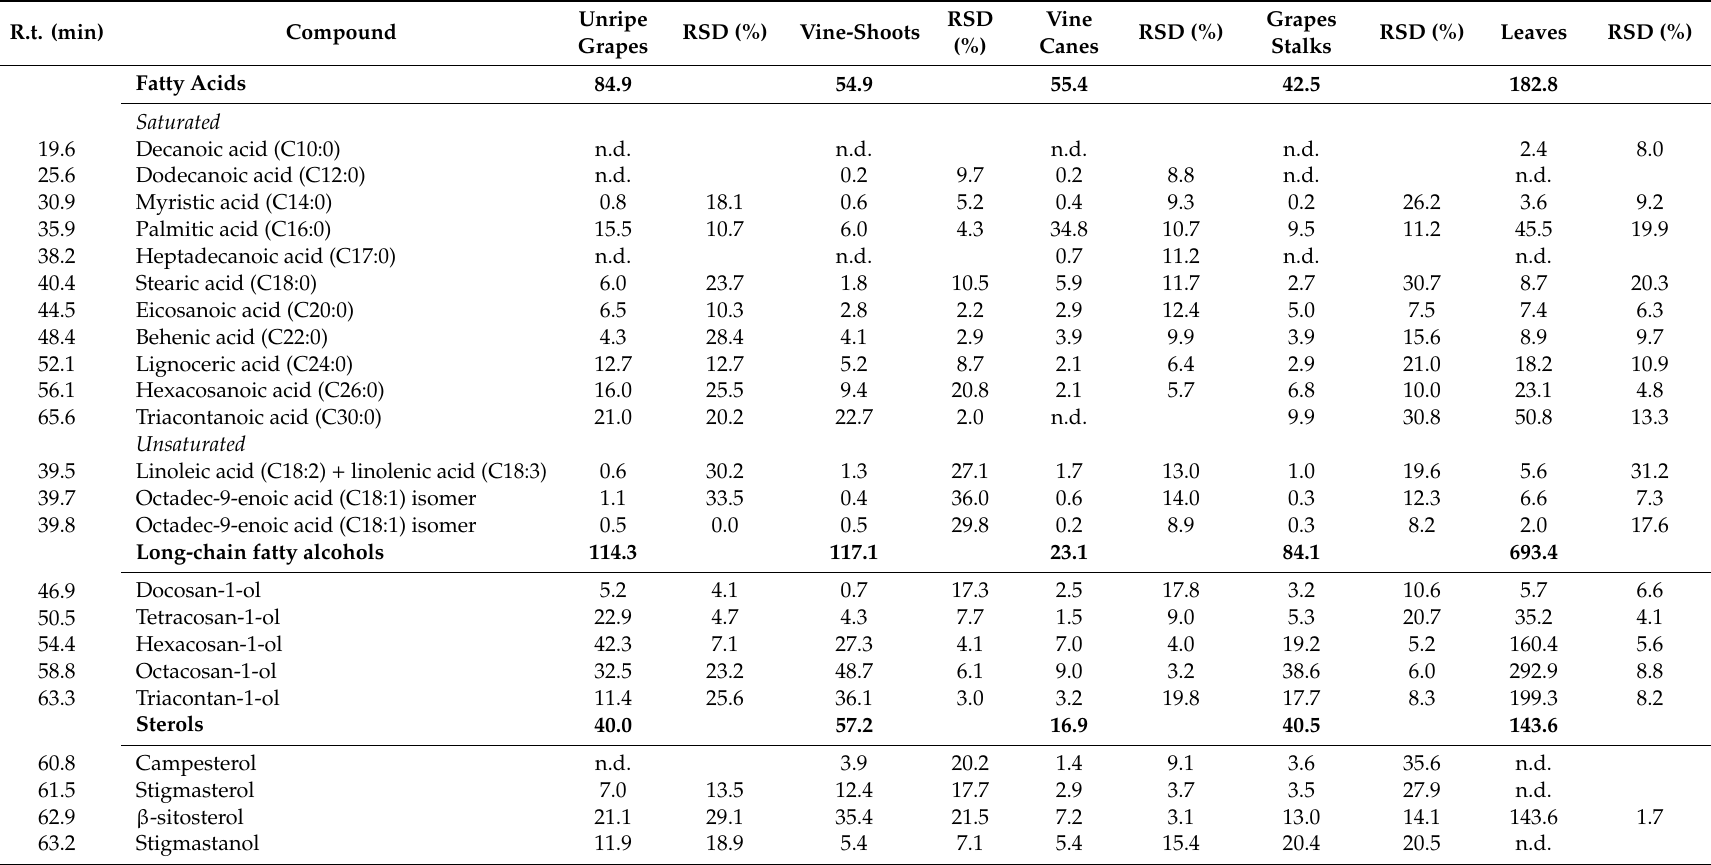
Table 1. Compounds detected in the lipophilic extracts from V. vinifera vine wastes expressed in mg / 100 g of dry